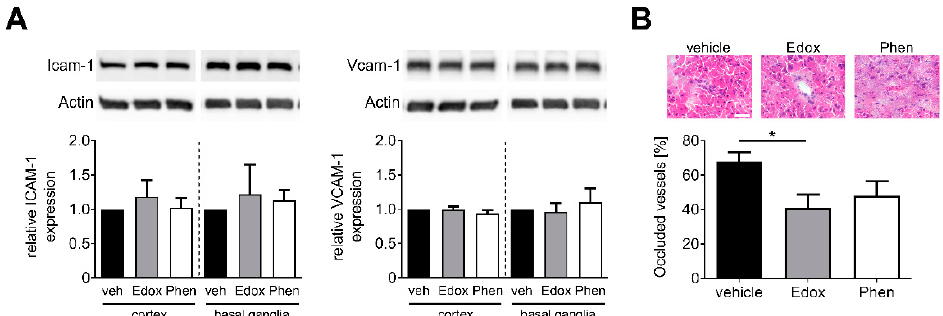
Figure 4. Edoxaban reduces intracerebral thrombosis. ( A ) Top : Intercellular adhesion molecule-1 (ICAM-1) and vascular cell adhesion molecule-1 (VCAM-1) protein expression in the ischemic cortices and basal ganglia of vehicle (veh)-, edoxaban (Edox)-, or phenprocoumon (Phen)-treated mice at day 1 after tMCAO as determined by immunoblot. Actin was used as loading control. Bottom : Densitometric quantification of ICAM-1 and VCAM-1 immunoreactivity in the ipsilateral cortex and basal ganglia of vehicle-, edoxaban-, or phenprocoumon-treated mice ( n = 4). ( B ) Top : Representative H&E stains in the ischemic hemisphere of vehicle-, edoxaban-, or phenprocoumon-treated mice 24 h after tMCAO (Scale bar = 50 µ m). Thrombotic vessels were shown in vehicle- and phenprocoumon-treatment groups, whereas an open vessel is shown for the edoxaban group. Bottom : Percentage of occluded vessels in the ischemic hemispheres of vehicle-, edoxaban-, or phenprocoumon-treated mice at day 1 after tMCAO ( n = 5). * p < 0.05.